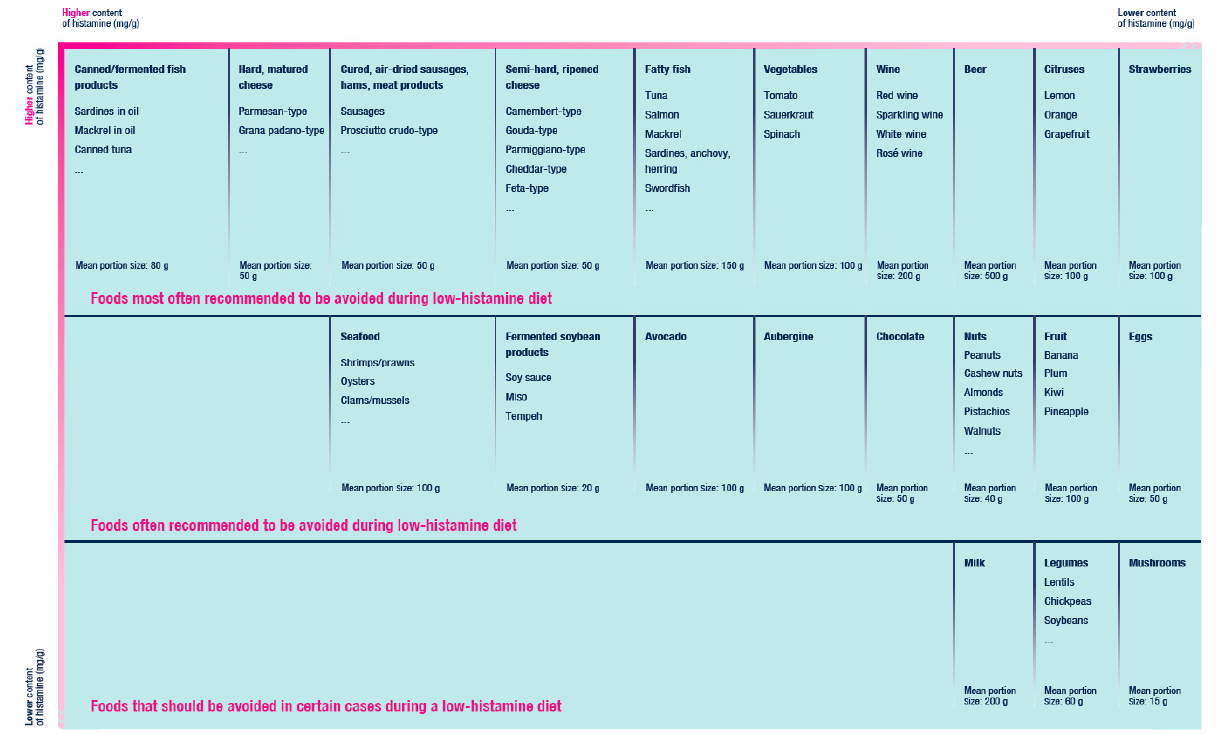
Figure 4. Foods that are most often recommended to be excluded from low-histamine diets. Adapted according to [9]. In Table 3, we list foods that in usual quantities are considered safe from triggering HIT symptoms. Table 3. Foods that in usual quantities are considered safe from triggering HIT symptoms. Adapted according to [40]. Water, coffee, tea, homemade juices from allowed fruits and vegetables Bread, pastry, potatoes, rice, pasta, cereals, millet, buckwheat,